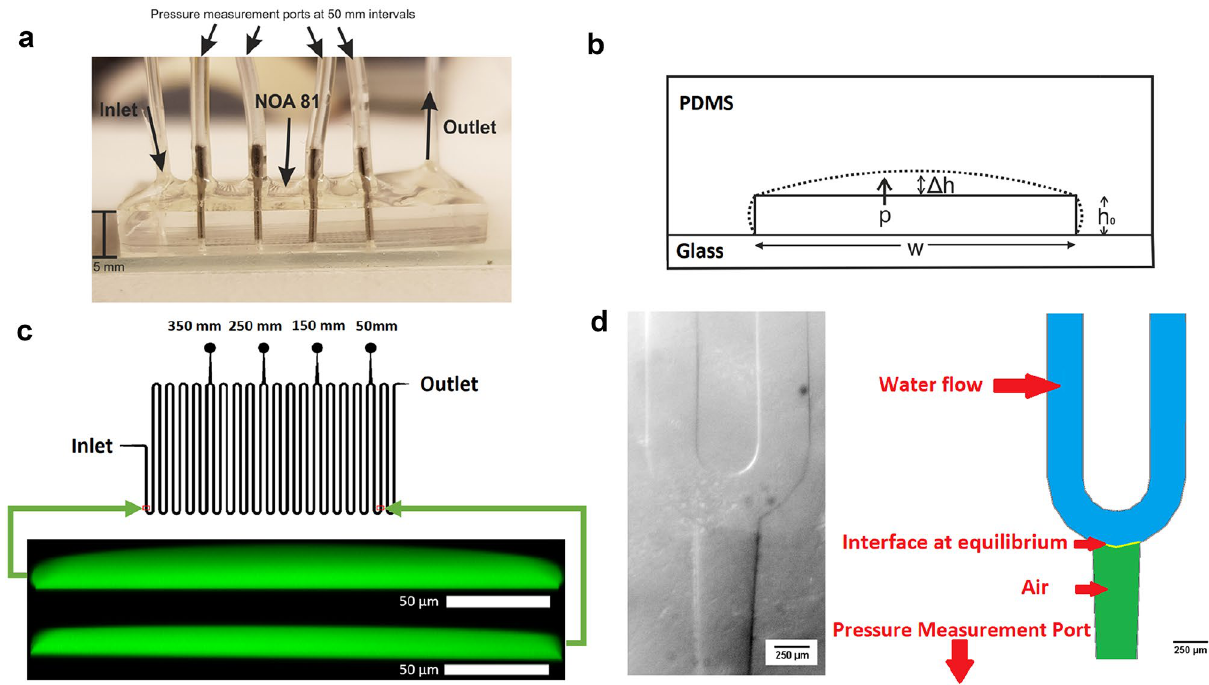
images of a channel containing fluorescein solution under a flow rate of 1800 μ l/h. Individual images taken at z intervals of 0.5 μ m are combined to show a 2D projection of the channel profile 460 mm and 110 mm from the outlet. Under no pressure, the channel height is 21 μ m and under pressure of an 1800 μ l/h flow, maximum heights of 48.41 μ m and 35.27 μ m were found, respectively. d The interface between injected liquid and pressurised air supply. Flow was initiated and air pressure adjusted until the interface was sta- ble. The pressure at each measurement point could then be